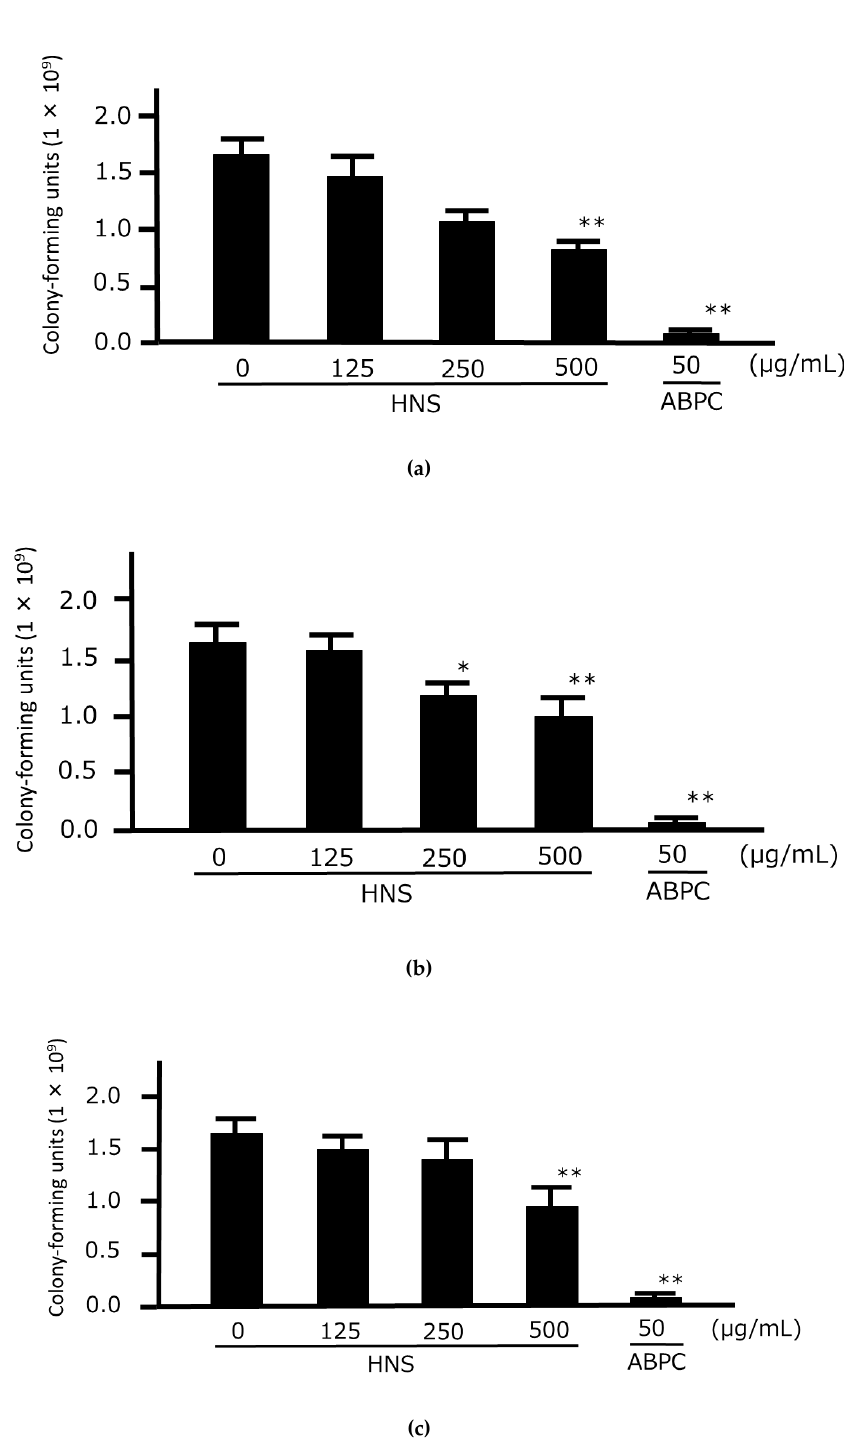
Figure 1. Growth-inhibitory effects of hainosan extract (HNS) against three Porphyromonas gingivalis isolates. P. gingivalis JCM12257 ( a ), JCM8525 ( b ), and JCM19600 ( c ) were treated with HNS for 48 h. An aliquot of each liquid culture was then inoculated onto a CDC anaerobic plate and cultured for 2 d in an